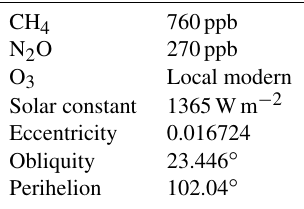
Table 2. Settings common to all experiments in the present study. These refer to the last 1000 years, before which the fol- lowing settings were used: 863.303ppbCH 4 , 279.266ppbN 2 O, 1366.12Wm − 2 solar